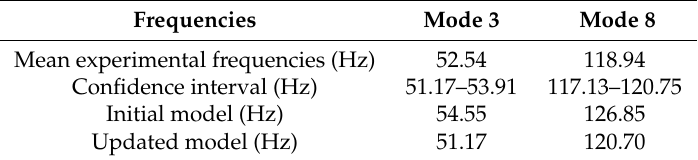
Table 6. Comparison between the confidence interval and the frequencies calculated by the numerical